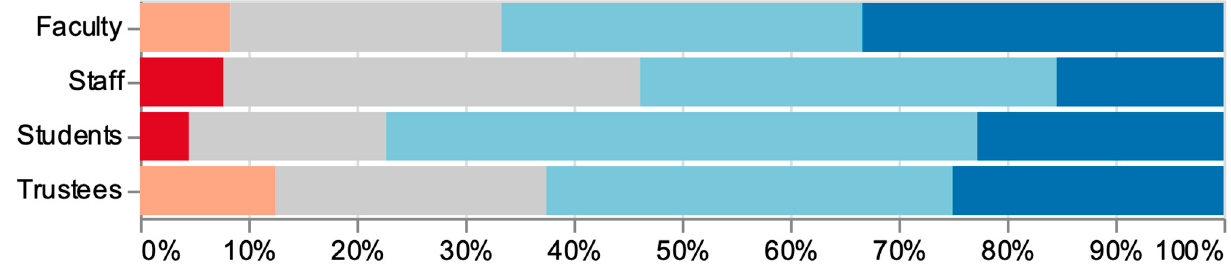
Figure 2. “Bivocational ministry is the future of pastoral ministry.” (Q1). 4% strongly disagree; 4% disagree; 25% neutral; 44% agree; 24% strongly agree.